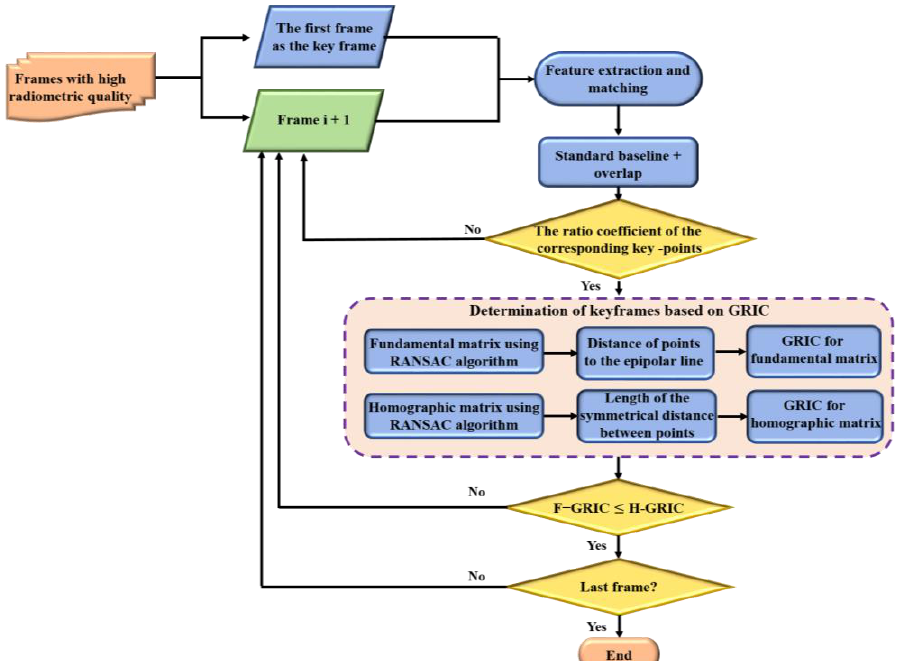
Figure 3. Flowchart of keyframes extraction with optimal